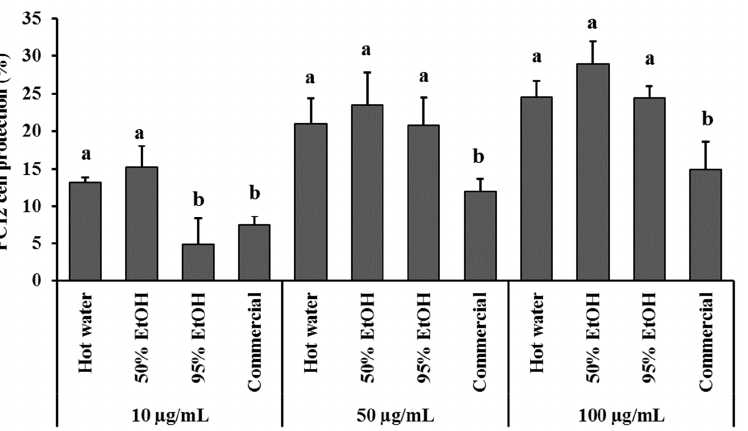
Figure 5. Effect of P. emblica L. fruit extracts on PC 12 cell protection against hydrogen peroxide (H 2 O 2 )-induced cell damage. Data are means ± SD ( n = 3). Values for different sample concentrations (10, 50 and 100 µg/mL) with different superscript letters (a and b) indicate a significant difference ( p <0.05) by Duncan’s multiple range test.